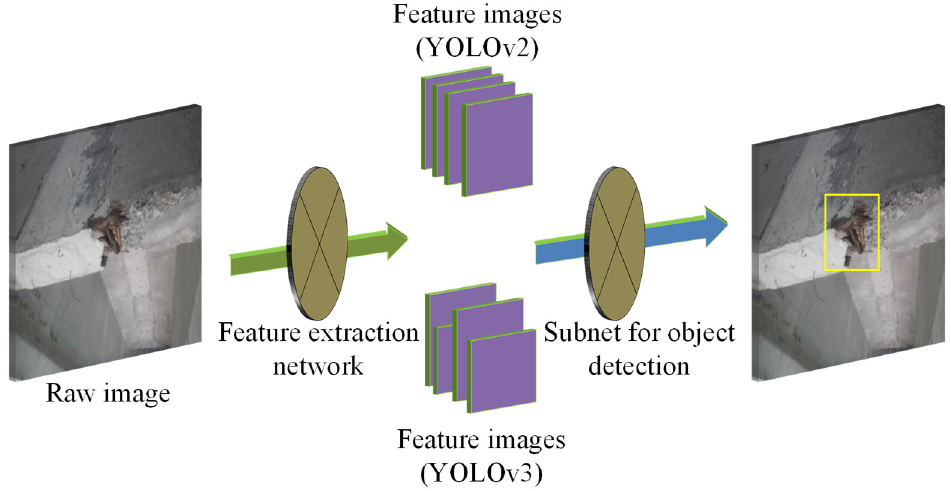
Figure 1. The YOLO Figure 1. The YOLO architecture.